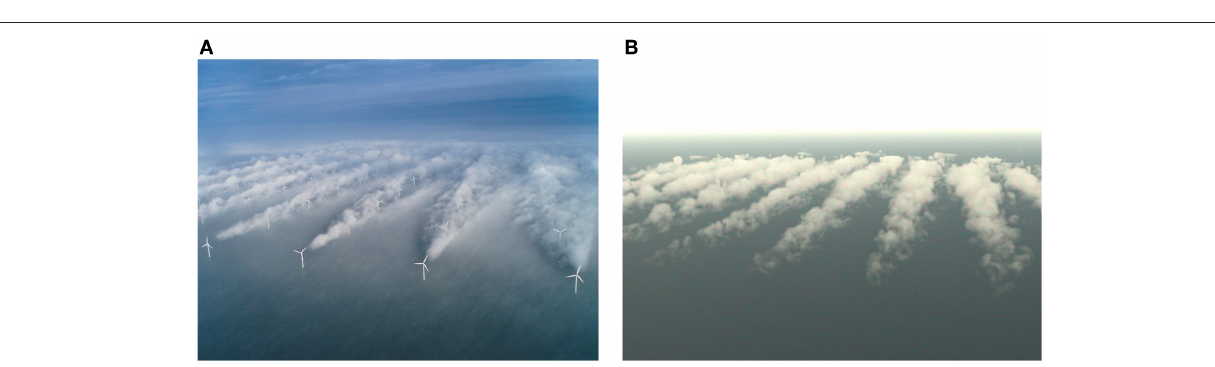
feature was the great similarity with the photographs, presenting the well developed spiral cloud pattern in each row of the wind farm. It should be mentioned that the liquid water is